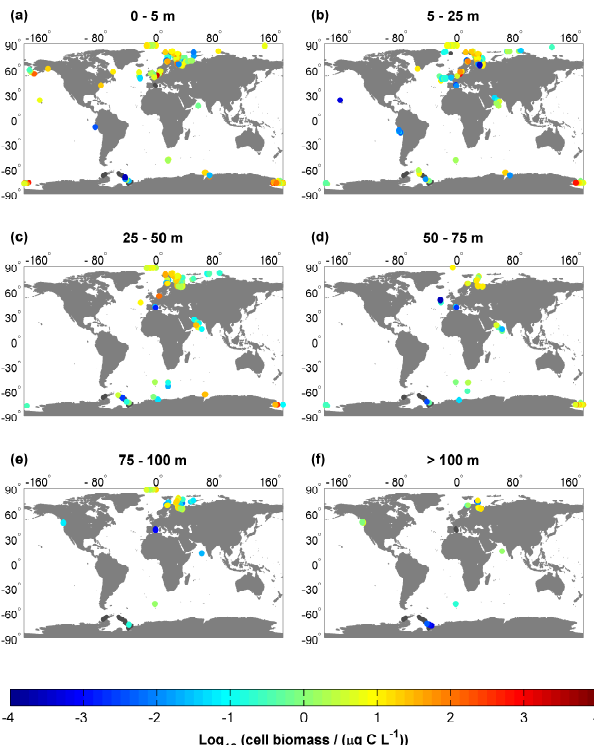
Figure 7. Log-normalized Phaeocystis cell biomass in units of car- Fig. 7. Log-normalized Phaeocystis cell biomass in units of carbon (µg C l − 1 ) at different depths (a) sur- bon ( µ gCl − 1 ) at di ff erent depths (a) surface measurements (0–5m) face measurements (0–5m) (b) measurements between 5–25m (c) 25–50m (d) 50–75m (e) 75–100m (b) measurements between 5–25m (c) 25–50m (d) 50–75m (e) 75– and (f) > 100m depth. Black dots represent zero biomass values. 100m and (f) > 100m depth. Black dots represent zero biomass val-